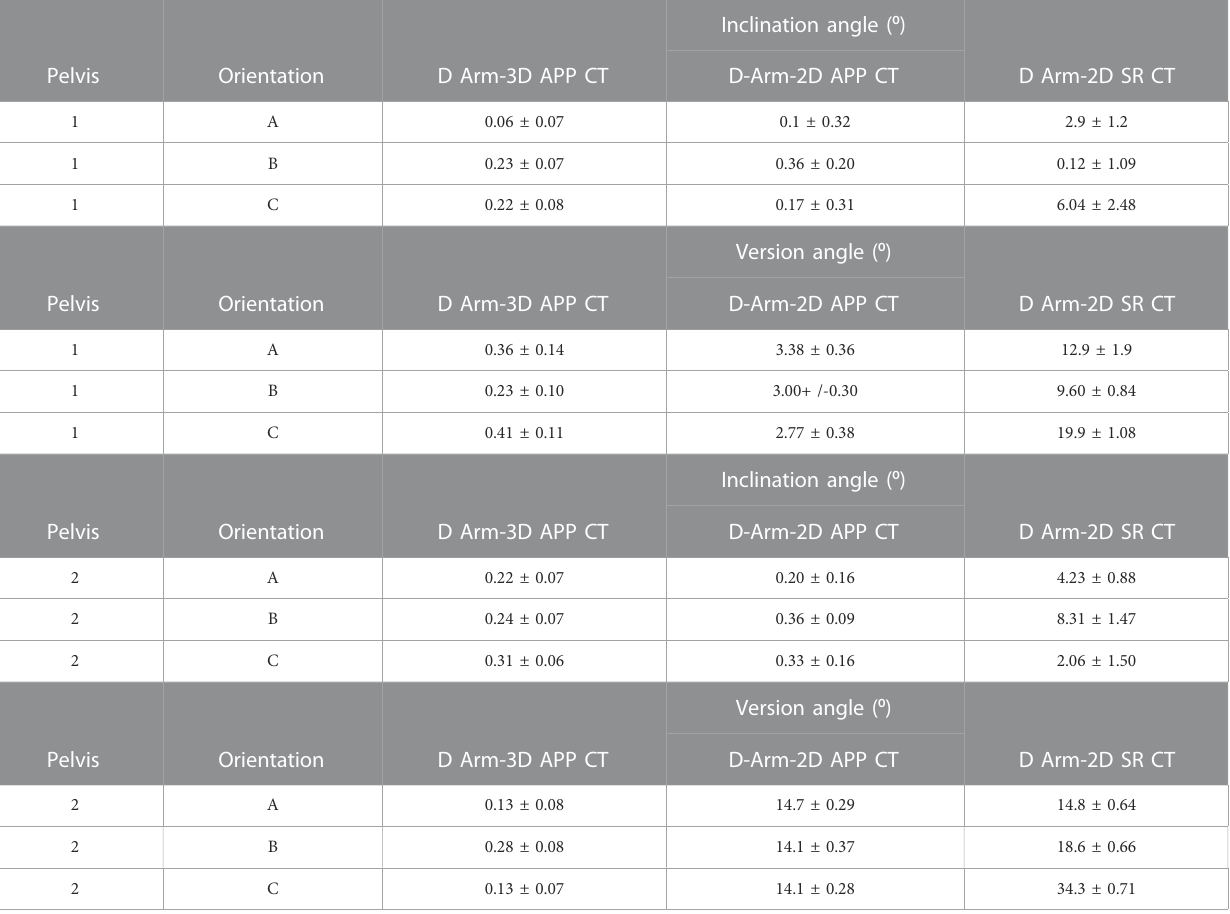
TABLE 1 Absolute mean (+/-2SD) difference between 12-paired coordinate measuring arm and CT measurements from observer 1 for both pelvises. 3 CT methods wereused(3DAPPCT,2DAPPCTand2DSRCT),eachwiththepelvis in3differentorientationsintheCTscanner.Measurementsweremadeofthe cupintermsof inclination and version